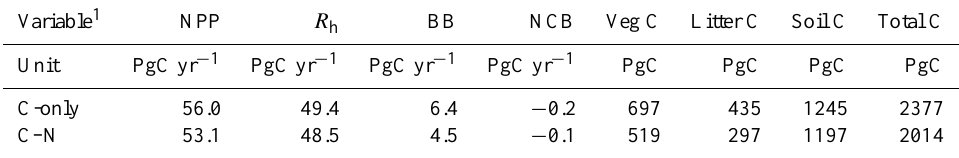
Table A2. Initial conditions for the C-only and C–N model versions, after spin-up.